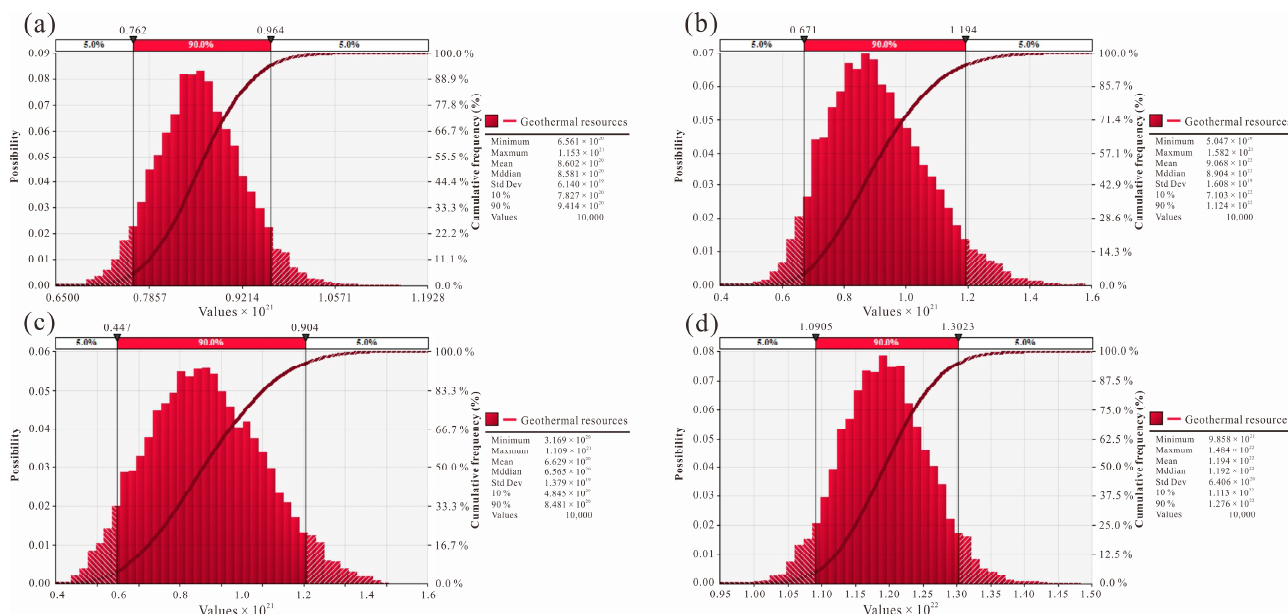
Figure 6. Simulation results for the primary thermal reservoirs in the North Jiangsu Basin (( a ) Yancheng thermal reservoir; ( b ) Sanduo thermal reservoir; ( c ) Dai’nan thermal reservoir; ( d ) carbonate thermal reservoir).